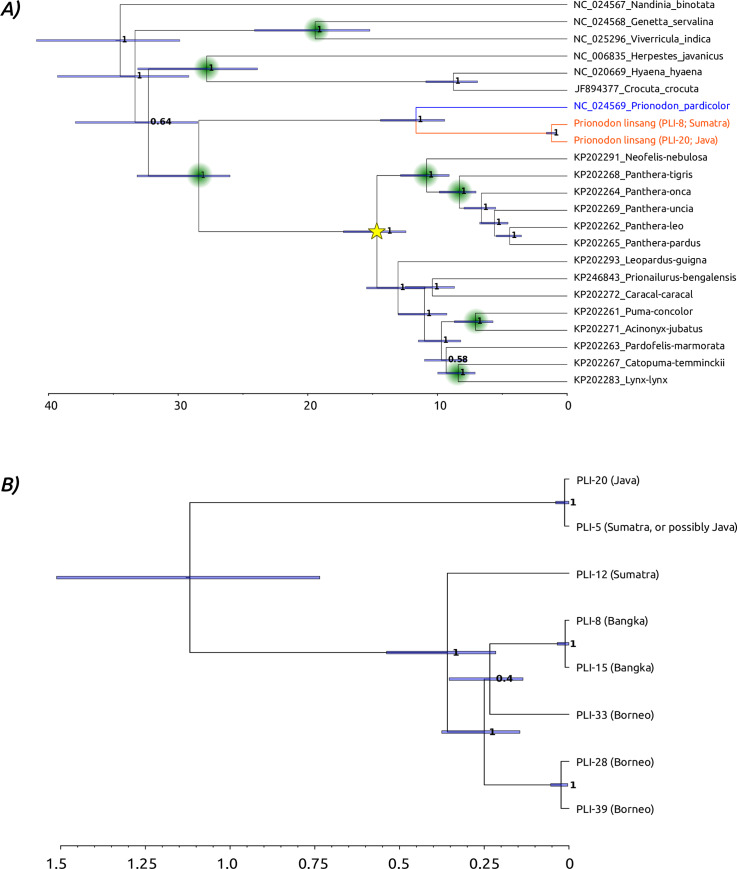
Linsang phylogenetic structure.A) Calibrated interspecific mitogenome phylogeny including a range of feliformia species. Calibrated nodes are indicated with green circles (S4 Table of S1 Data), and the ancestral bait sequence used for capture is indicated with a yellow star. Colours for the linsang taxa correspond to the distribution displayed in Fig 1. B) Calibrated mitogenome phylogeny of the banded linsang. On both panels, node labels indicate the Bayesian Posterior Probability, blue node bars indicate the 95% credibility interval of the posterior sampling of the node. Bottom axis indicates the age in millions of years.